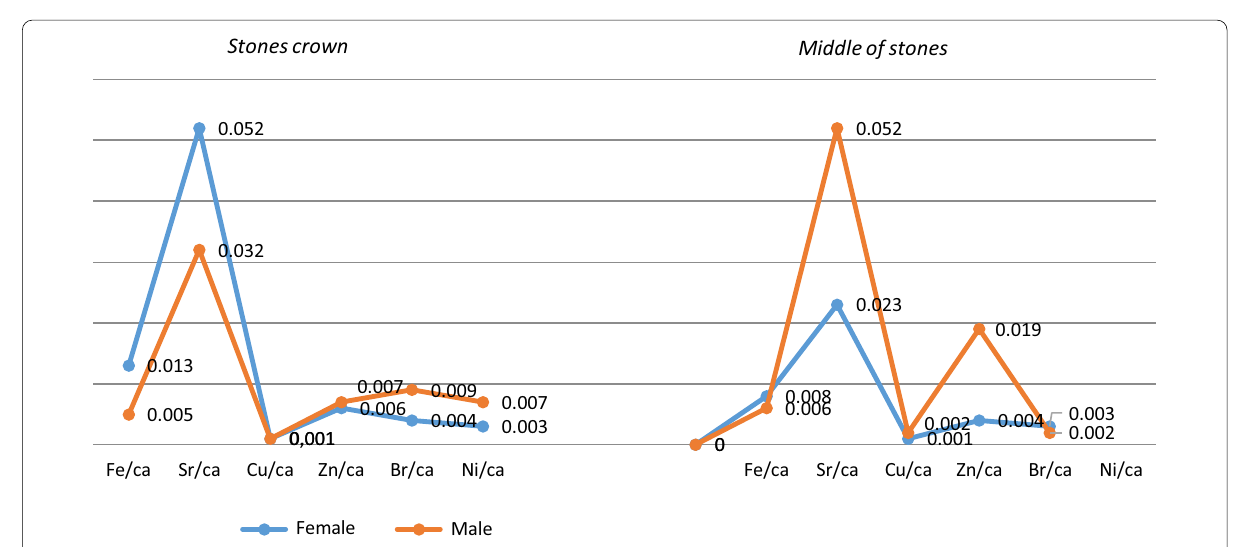
Fig. 3 Mean metal / calcium ratio of oxalo‑calcium stones by